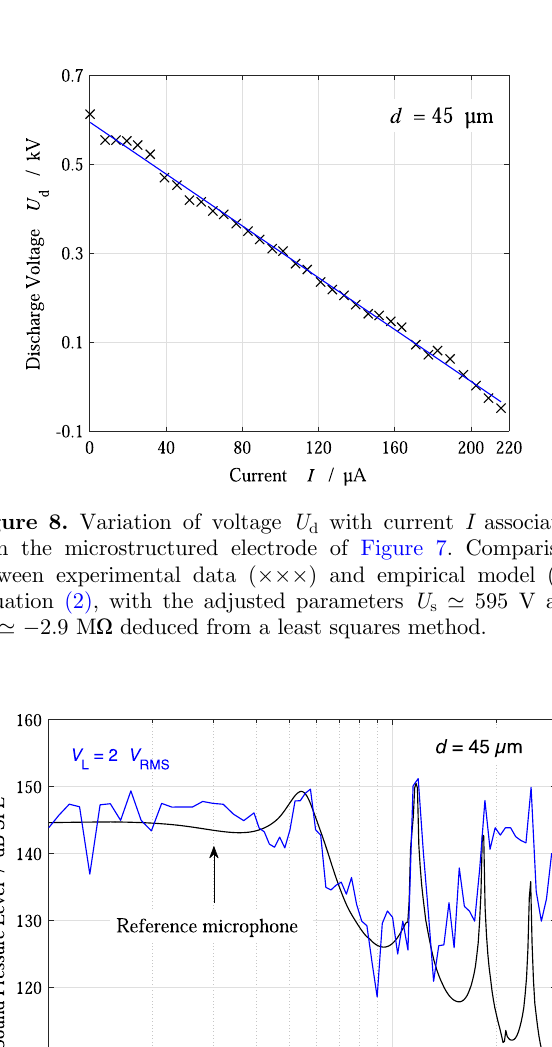
Figure 7. Schematic representation of the microdischarge microphone. The cathode is a disk-shaped electrode. Both anodes are ring- shaped, only one is used. d = 45 l m and D = 60 l m. R ’ 23 M X and r ’ 50 X are the values of the ballast and shunt resistance.